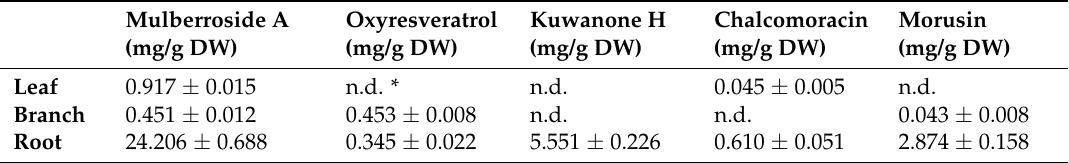
Table 1. Contents of five secondary metabolites in different organs of Morus